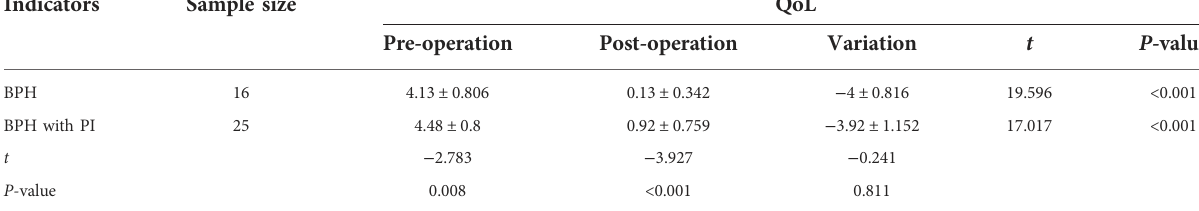
TABLE 4 Comparison of QoL data between two groups before and after surgery